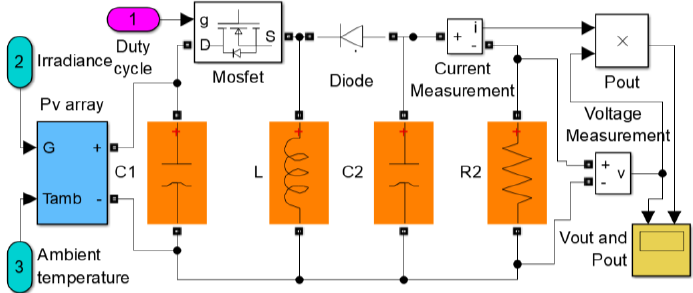
Figure 4. Buck–boost converter with PV array and input capacitor.